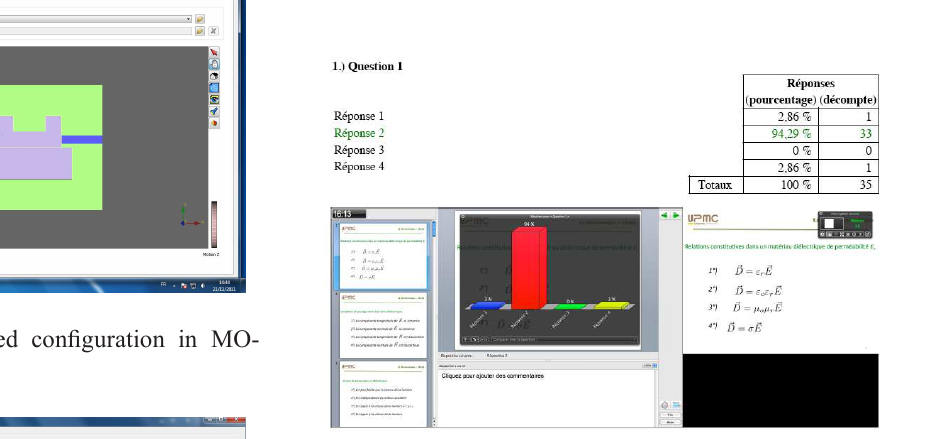
Figure 6: TurningPoint R (cid:13) AnyWhere TM device